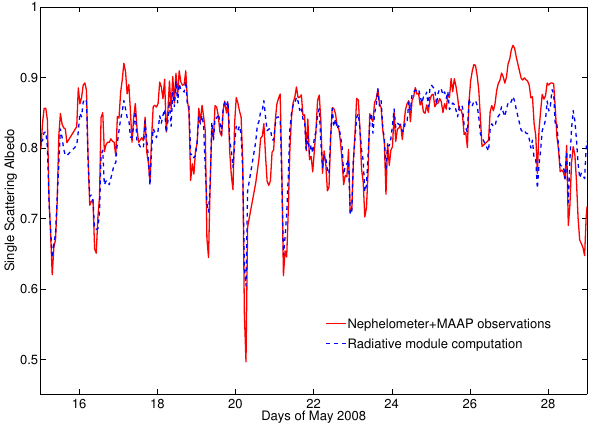
Fig. 10. Evolution of the dry single scattering albedo at 550nm measured at Cabauw during EUCAARI by the nephelometer and the MAAP, and computed by the